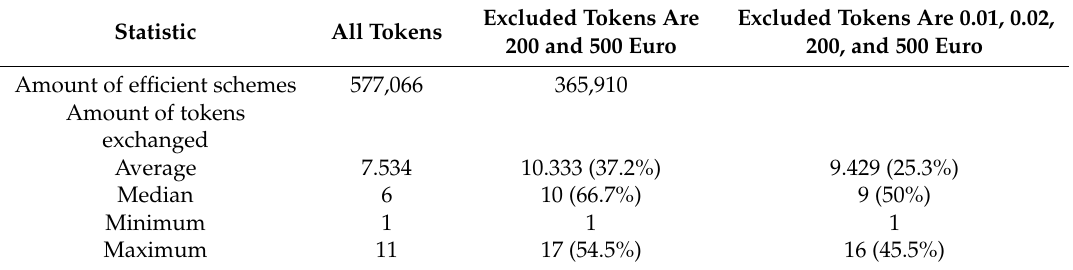
Table 2. Results for Euro on efficient payment schemes (percentage increase, relative to the all tokens case) in